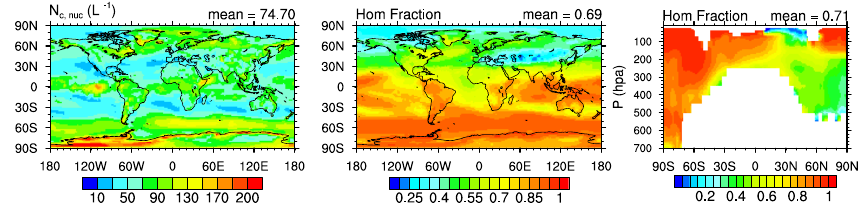
Figure 7. Annual mean ice crystal concentration nucleated in cirrus ( T < 235K) weighted by cloud fraction for the NEW run (left panel). Also shown are the weighted average (center panel) and zonal mean (right panel) fractions of ice crystal production by homogeneous freezing in cirrus.